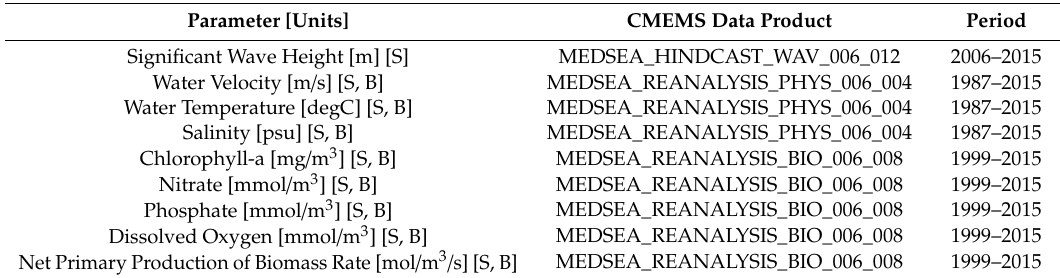
Table 2. Hydrographic and water quality parameters retrieved from CMEMS and periods these data cover. S, B represent Surface / Bottom